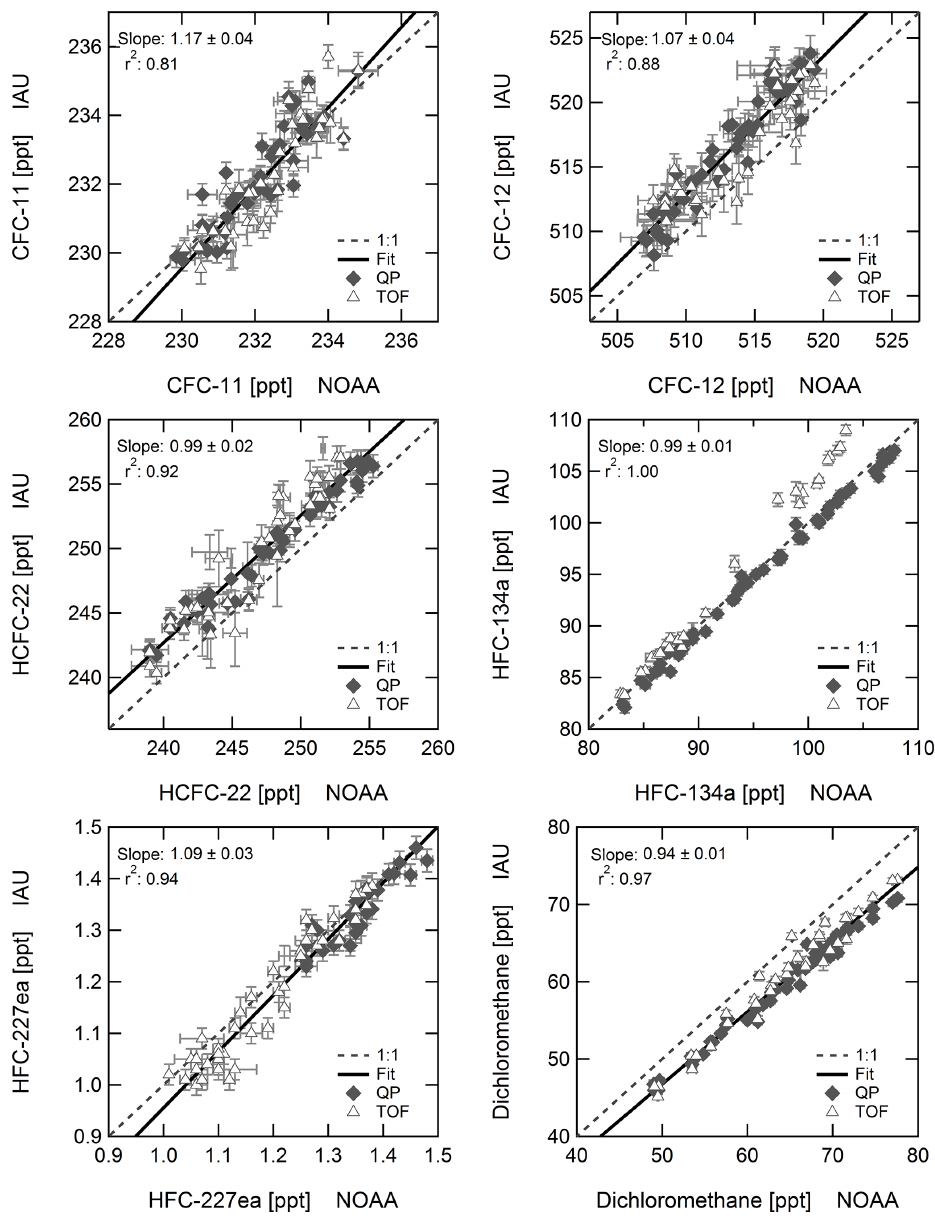
Figure 3. Correlation of CFC-11, CFC-12, HCFC-22, HFC-134a, HFC-227ea, and dichloromethane in Frankfurt flask samples (IAU) with canister samples of the NOAA network analysed by GC/MS (data available at ftp://ftp.cmdl.noaa.gov/hats/, last access: 7 August 2018) at Mace Head. Results from the Frankfurt GC/MS system are reported on SIO scales resulting in a constant offset for some substances. Because of the known non-linearity of the TOF instrument, for HFC-134a the correlation parameters are derived for the QP mass spectrometer only.